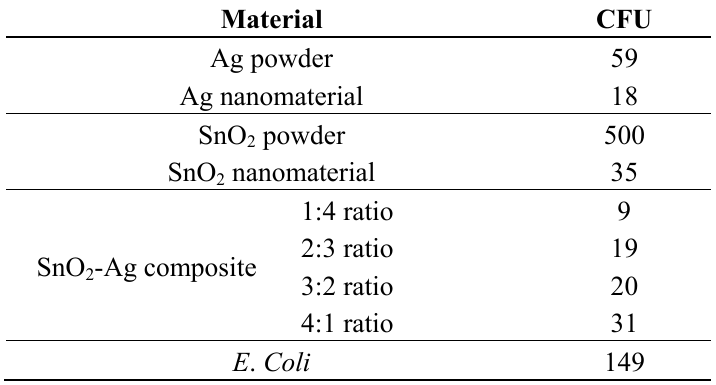
Table 2. Colony forming units (CFU) vs . material